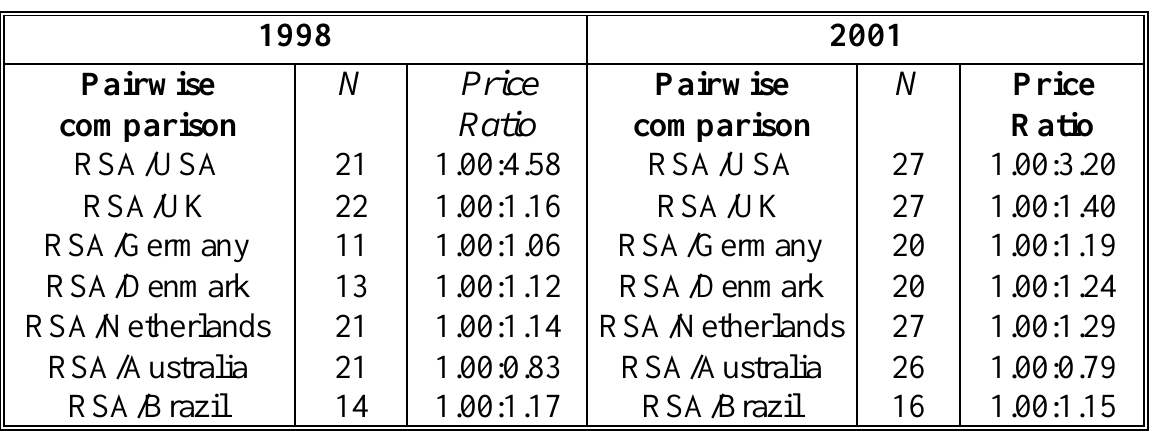
Eight country comparison -top 80